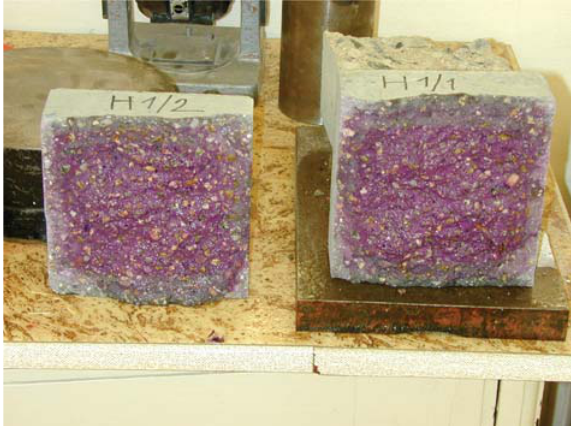
Fig. 2. Sample of formulation H placed in 0.03% CO 2 (internal laboratory environment) for 365 days, average carbonation depth 1mm, real sectional dimensions of sample: 150×150 mm (Scale: